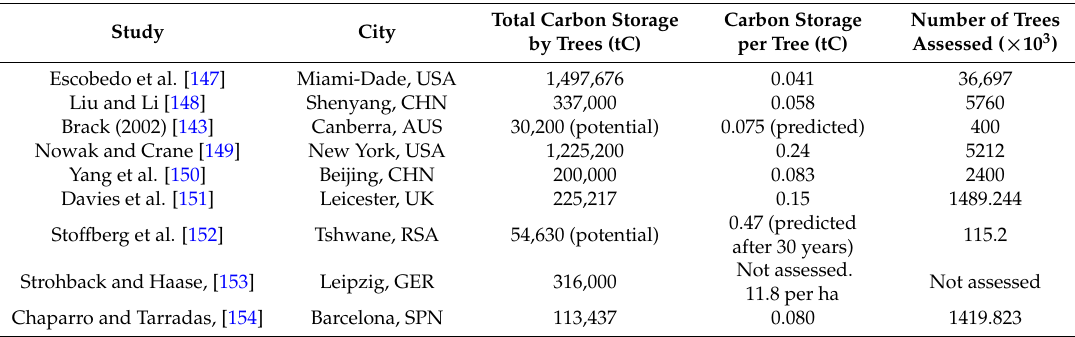
Table 2. Carbon storage (or potential carbon storage) by trees in selected world cities. Based on the number of trees assessed in each